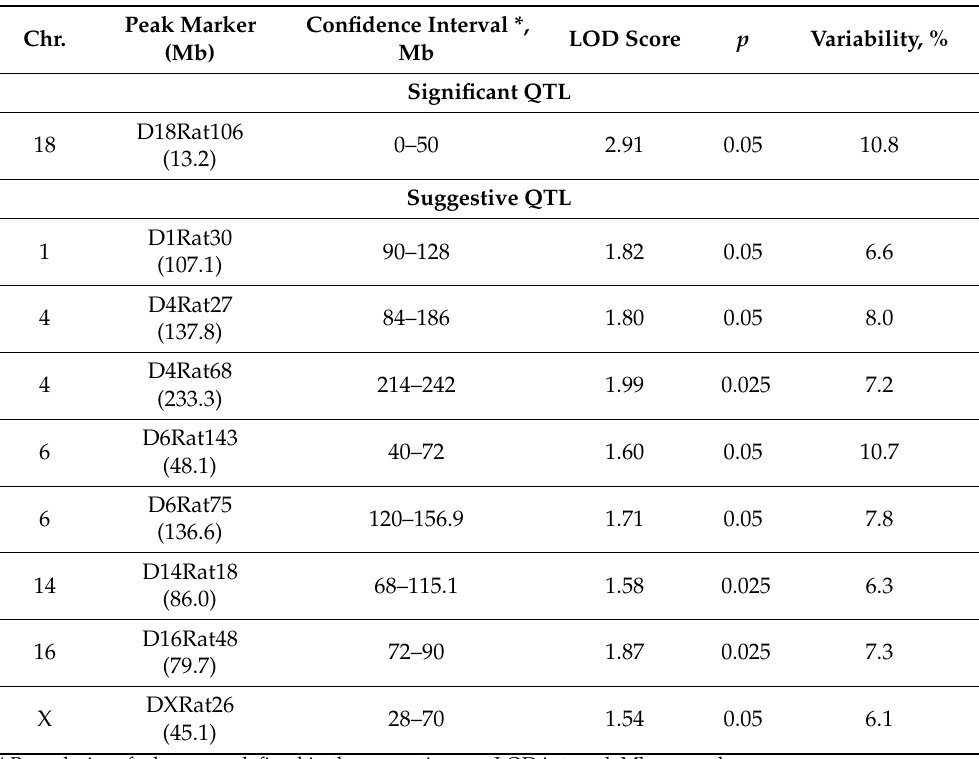
Table 2. Quantitative Trait Loci (QTL) associated with concentration of norepinephrine in the hypothalamus in male rats F 2 (ISIAHxWAG) aged 6 months. Chr.